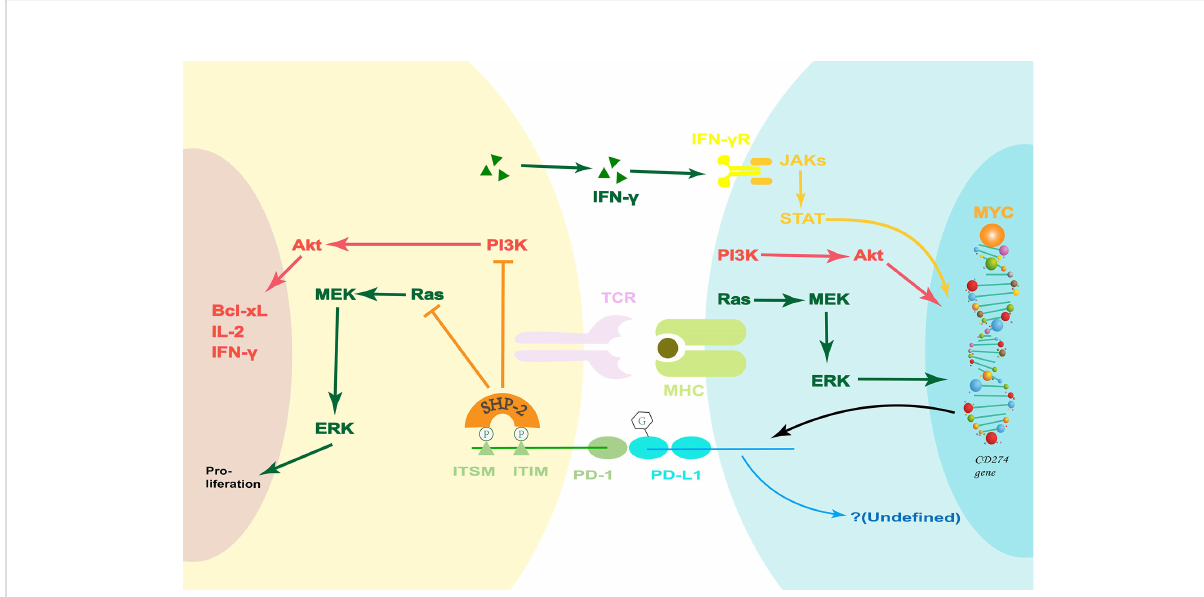
FIGURE 2 The PD-1/PD-L1 pathway. PD-1 ligation inhibits the PI3K-Akt and Ras-MEK-ERK signaling pathways. Coincidentally, the PI3K-Akt and Ras-MEK- ERK pathways are upstream signals that regulate PD-L1 expression. Moreover, IFN- g can increase the PD-L1 expression via the classical JAK- STAT pathway during in fl ammation. However, the potential PD-L-associated downstream signaling pathways are unde fi ned, and they may hold the key to how the PD-1/PD-L1 pathway regulates the innate immune response. Bcl-xL, B-cell lymphoma-extra large; ERK, extracellular signal- related kinases; IFN, Interferon; ITIM, immunoreceptor tyrosine-based inhibitory motif; ITSM, immunoreceptor tyrosine-based switch motif; JAK, Janus kinase; MEK, mitogen-activated extracellular signal-regulated kinase; MHC, major histocompatibility complex; PD-1, Programmed death 1; PD-L1, PD-1-ligand 1; PI3K, phosphatidylinositol 3-kinase; SHP-2, Src homology 2 domain-containing protein tyrosine phosphatase-2; STAT, JAK2 signal transducer and activator of transcription; TCR, T-cell